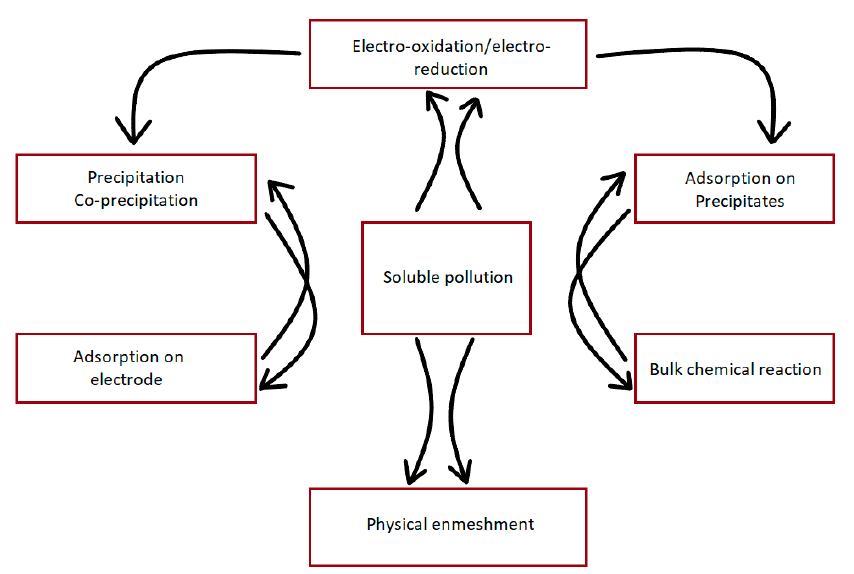
Figure 3. The main mechanism of soluble pollutant abatement using EC [99].